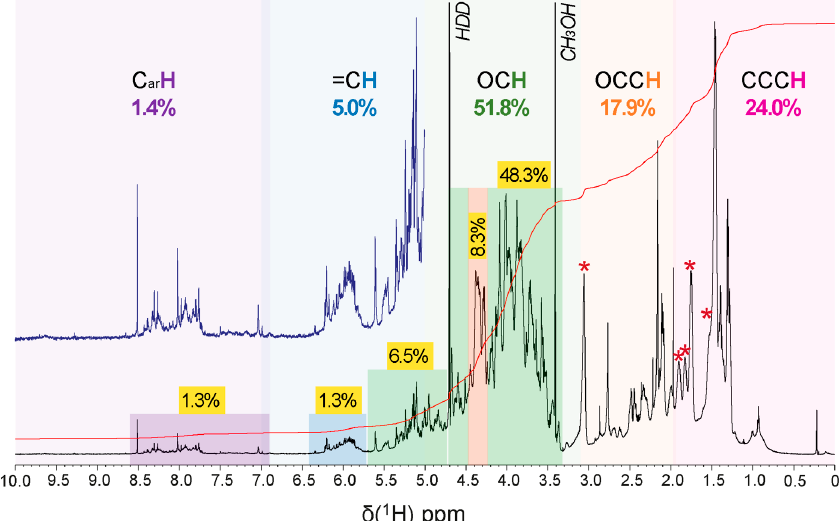
Figure 5. 1 H NMR spectrum (800 MHz, D 2 O) of R. tataouinensis EPS reveals a considerable structural complexity, with the key substructures (C ar H , purple, =C H and O 2 C H , blue, OC H , green, NC H and OCC H , orange, and CCC H , red) and relative abundance (% of 1H NMR section integral) indicated. A stronger green shade denotes carbohydrate-related OC H and O 2 C H units, a red shade probably indicates peptide CONHC α H units, a blue shade denotes olefinic =C H units, and a purple shade denotes aromatic C ar H units; asterisk denotes an extended aliphatic spin system, cf. Figures S6 and S7.